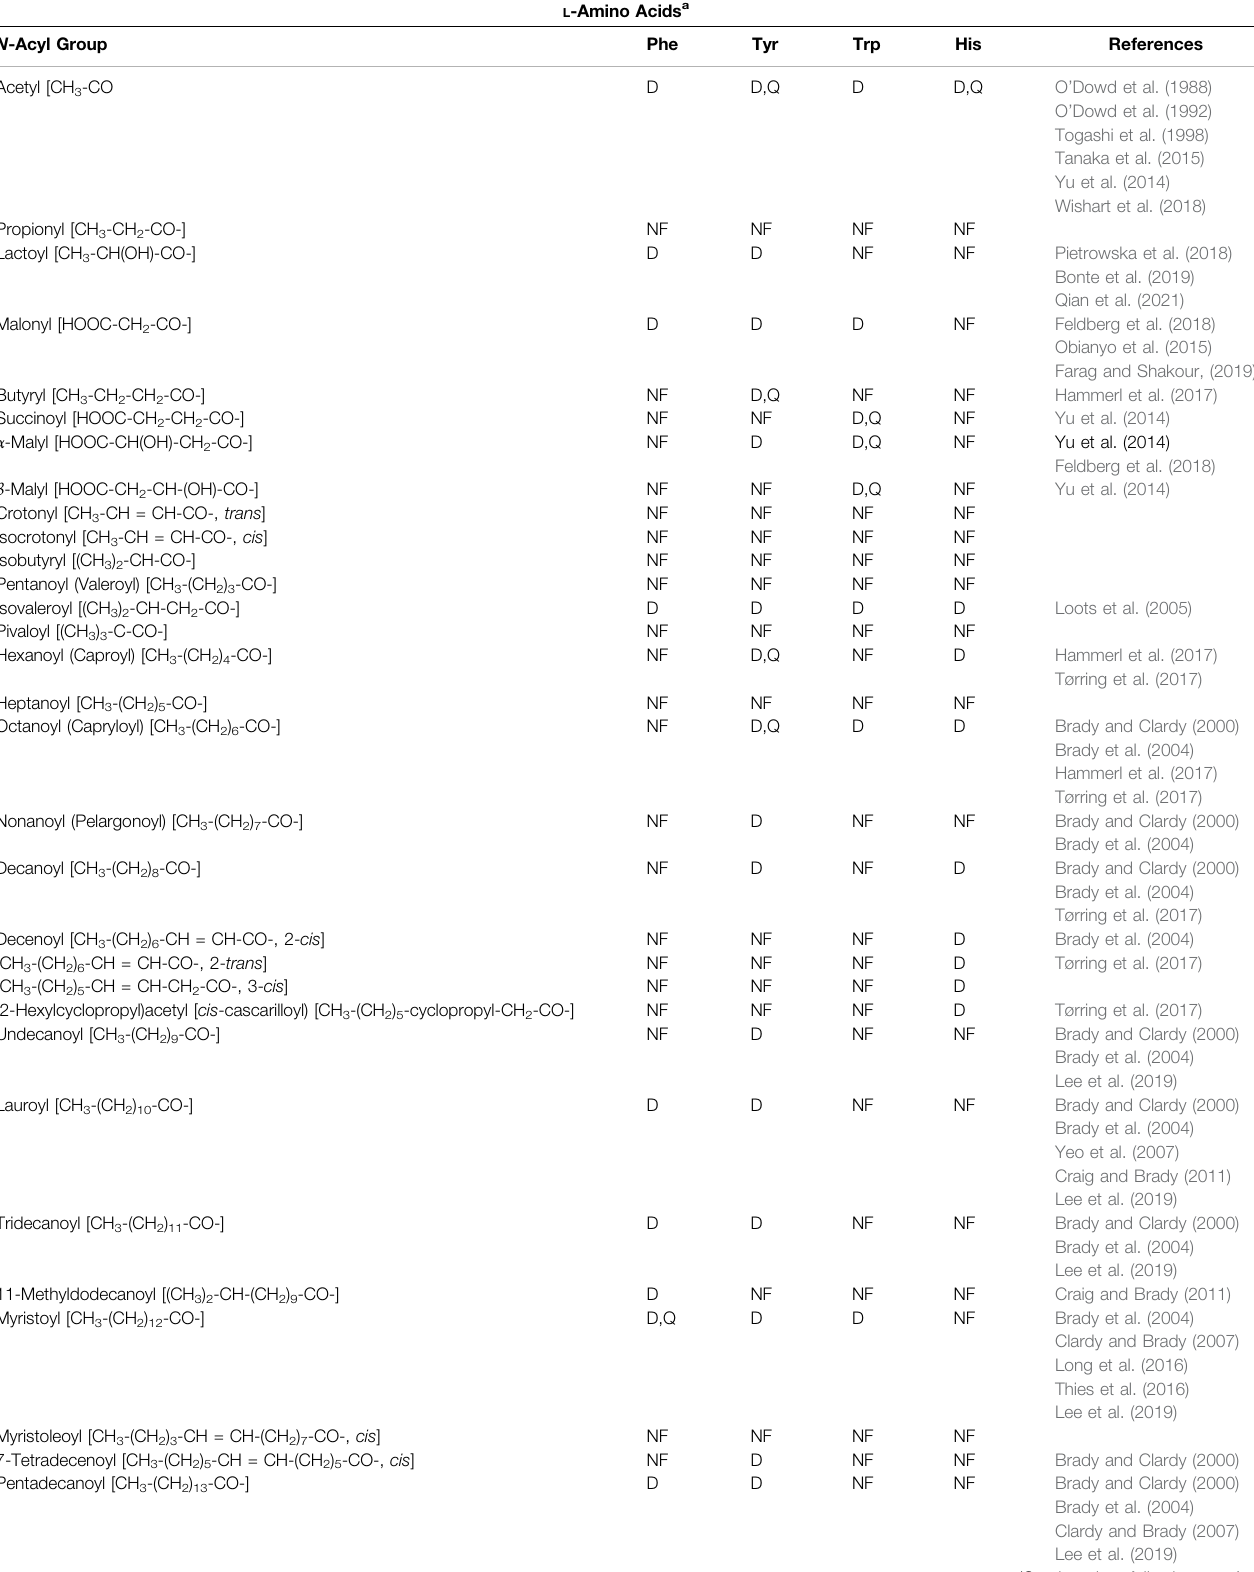
TABLE 1 | N -Acyl Aromatic Amino Acids Identi fi ed from Living